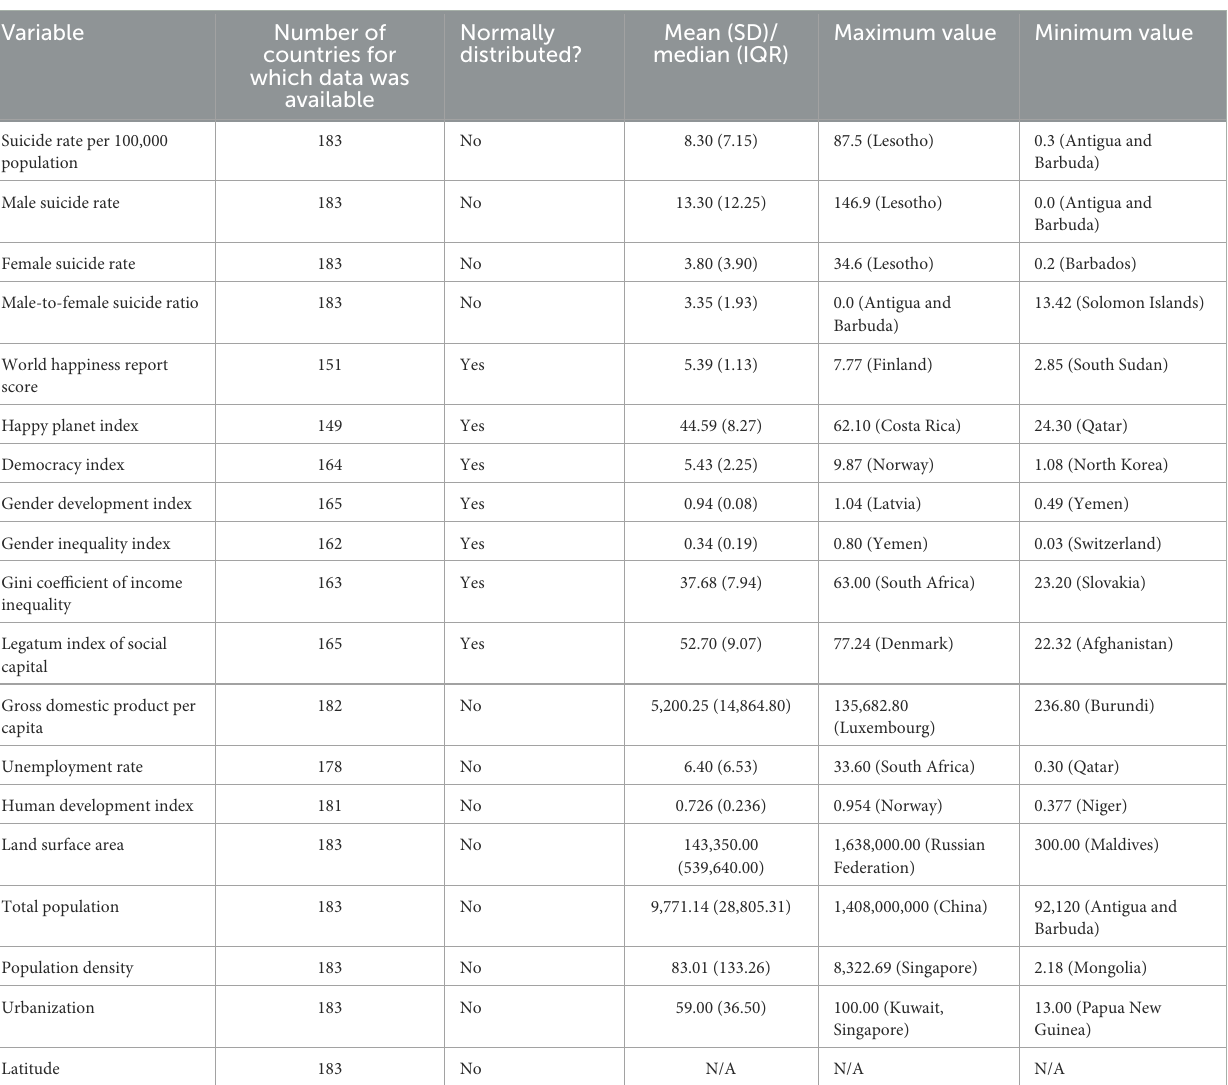
TABLE 1 Descriptive statistics for all indices included in the current study. Variable